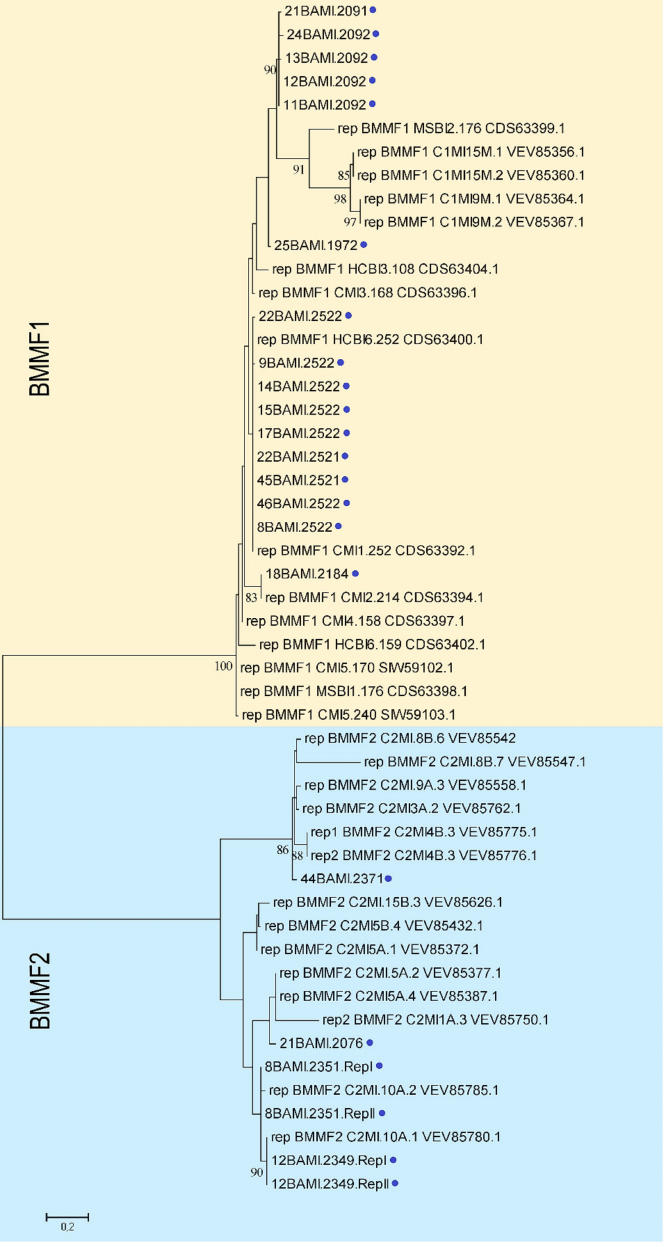
Figure 4. Maximum likelihood phylogenetic tree of Rep amino acid sequences and representative Reps from BMMF1 and 2 isolates calculated as described in Figure 1 [36]. The bootstrap consensus tree is based on 500 replicates. Bootstrap values at the branch points indicate the percentage of replicate trees in which respective isolates clustered [35]. Branch support values lower than 70% were not included. Blue dots mark all sequences found in this study. The scale bar represents the number of substitutions per site. All taxa are indicated by name followed by the corresponding GenBank accession